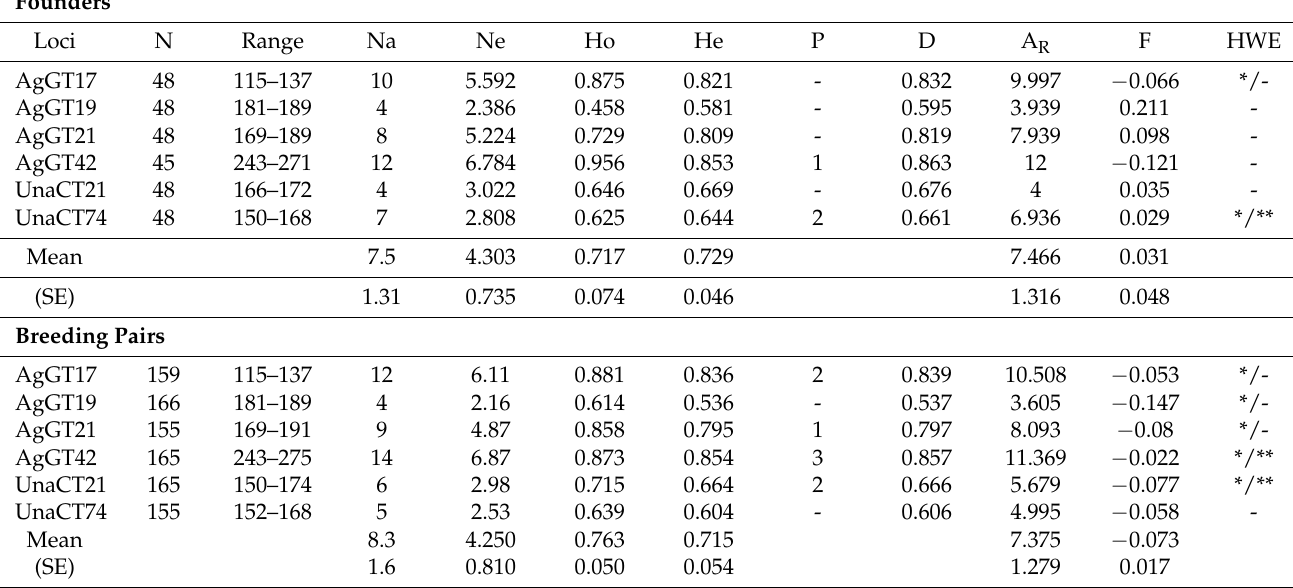
Table 1. Estimates of population genetic parameters for founders and breeding pairs from the Xcaret scarlet macaw population, including number of individuals (N), number of alleles (Na), effective number of alleles (Ne), observed heterozygosity (Ho), expected heterozygosity (He), private alleles (P), Nei’s gene diversity (D), allelic richness (A R ), and inbreeding coefficient (F). * Significant ( p < 0.05). ** Significant ( p < 0.05) after correction using Bonferroni